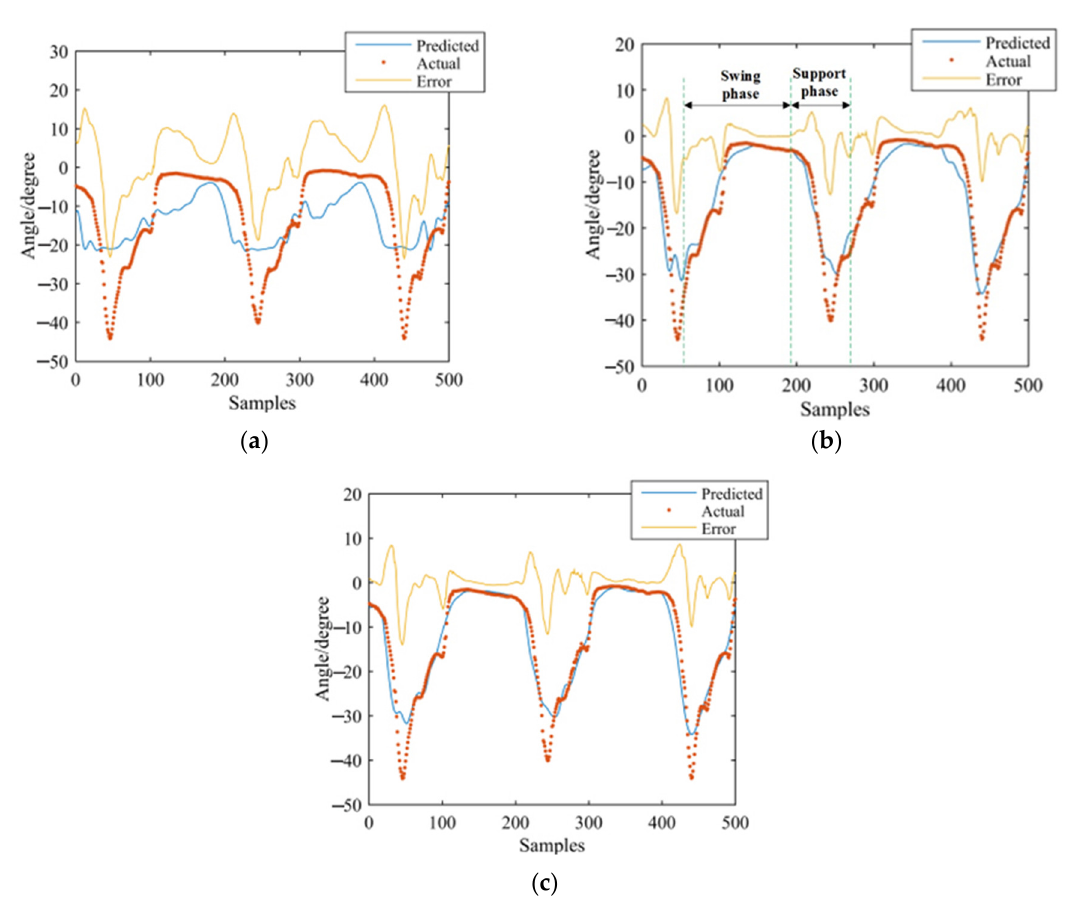
Figure 18. Prediction results of ankle-joint angle in the going downstairs process. ( a ) Results of IN1; ( b ) Results of IN2; ( c ) Results of IN3.